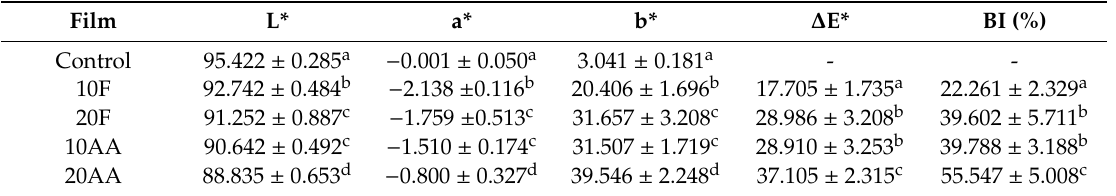
Table 3. CIELab parameters (L*, a*, b*), total colour difference ( Δ E*) and brown index (BI) for gelatin films as a function of cross-linker type and content.